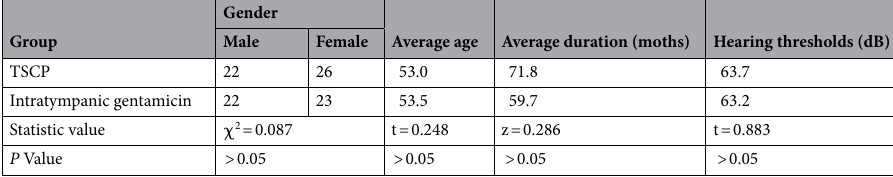
Table 1. The demographic information of patients with TSCP and intratympanic gentamicin patients.